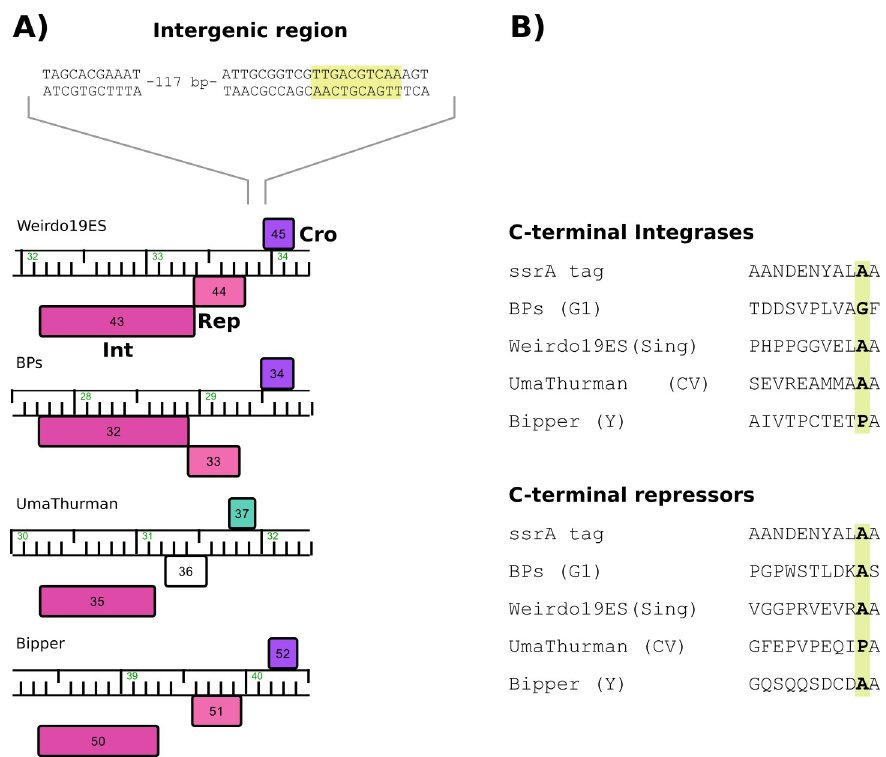
Fig 4. Analysis of the integration system. A) Graphical representation of the organization of integration system. The integration module of the Weirdo19ES, BPs, UmaThurman and Bipper were extracted from Phamerator, where the color indicated the assigned pham. Rep protein from UmaThurman phage could not be assigned to any pham (white box). The intergenic region between rep and cro genes was analyzed and a palindromic sequence was identified as indicated by a yellow box. B) The C-terminal sequence of the repressors and integrases were aligned with the ssr A proteolytic tag of the M . smegmatis , where the conserved alanine residue is